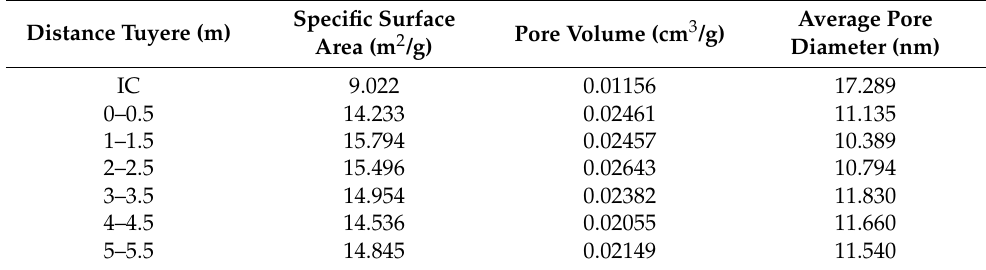
Table 5. Micropore parameters of different radial cokes.